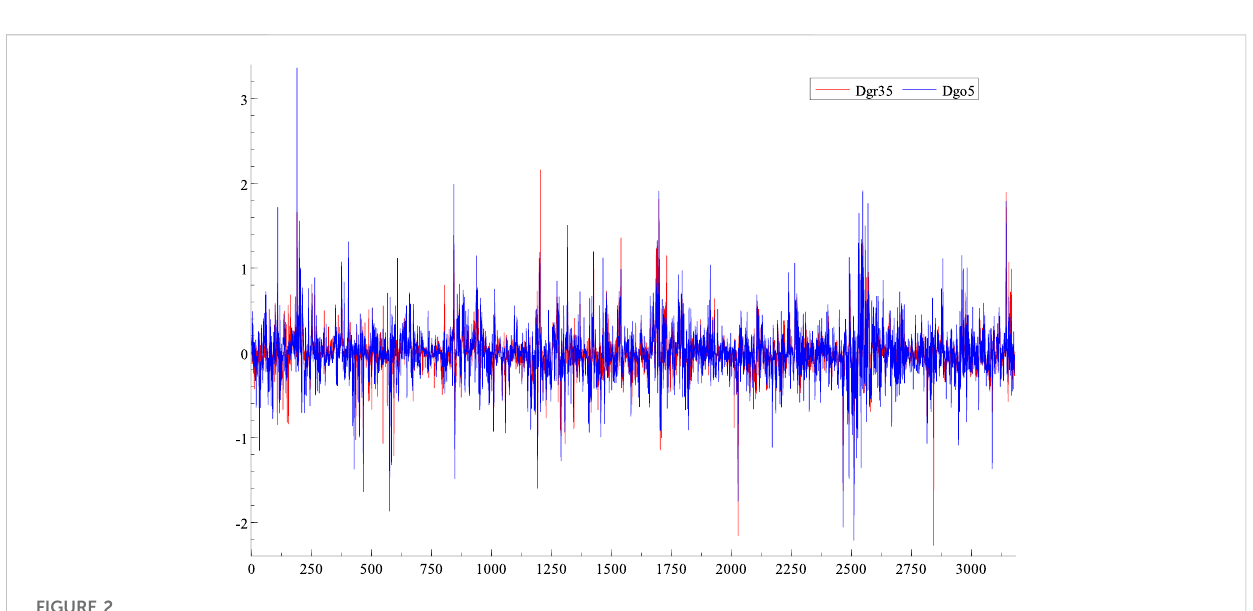
FIGURE 2 The volatility clustering effects of Dgr35 and